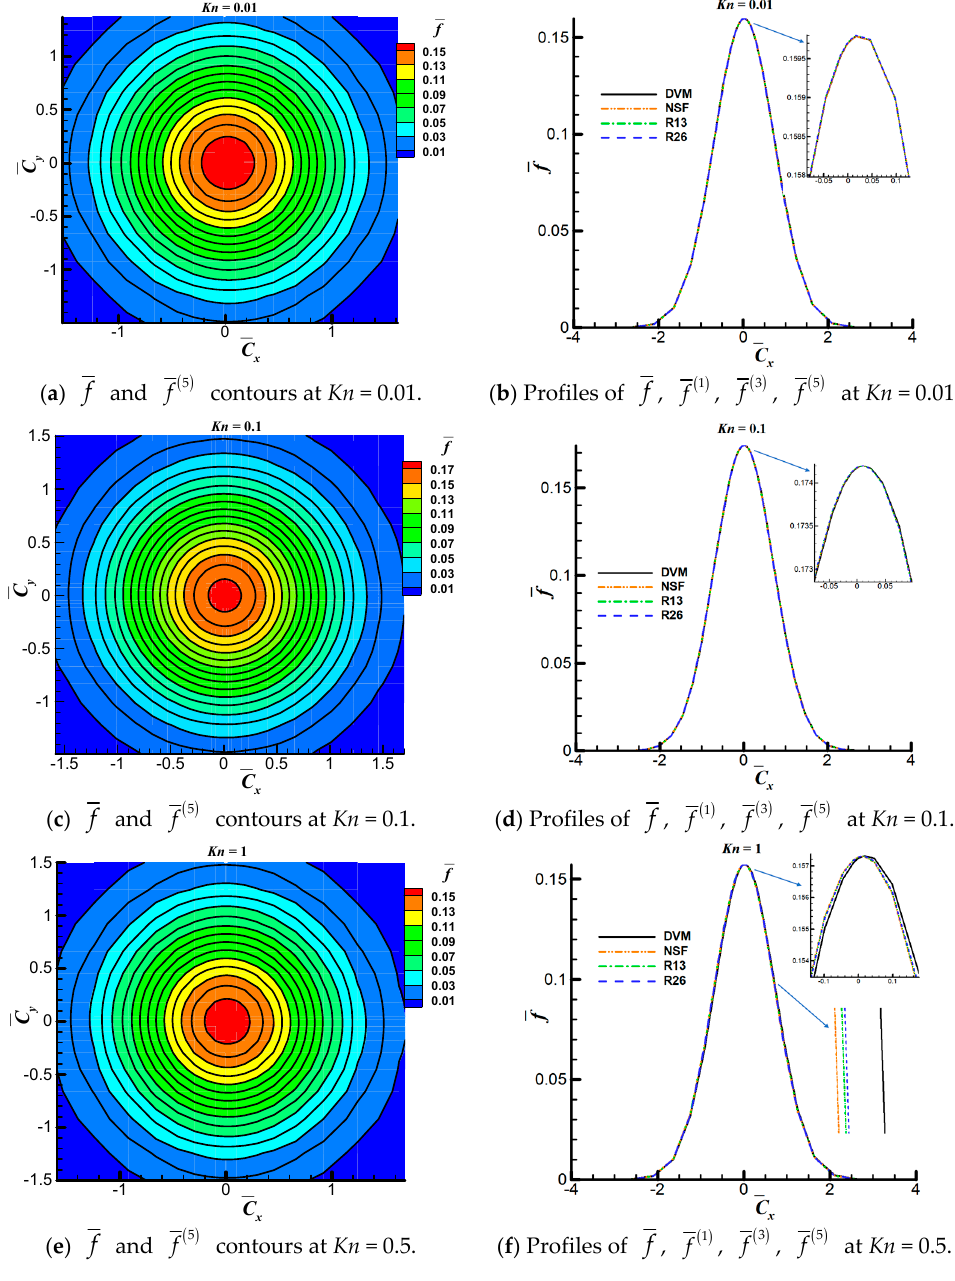
Figure 2. Comparison of the dimensionless VDF f with f , f and f at ( a , b ) Kn = 0.01; ( c , d ) Kn = 0.1; ( e , f ) Kn = 1. Left panel of the figure, contours: VDF obtained from the DVM; lines: f obtained from the R26 moment solutions. Right panel of the figure, VDFs against the dimensionless molecular velocity C x = C x / 2 RT 0 along the molecular velocity cross-section where C y = 0, C z = 0. And the terms: ‘NSF’, ‘R13 (cid:48) , ‘R26 (cid:48) corresponding to f , f , f reconstructed from the NSF solutions and R13, R26 moment solutions, respectively. The same notations are also used in the following figures unless otherwise